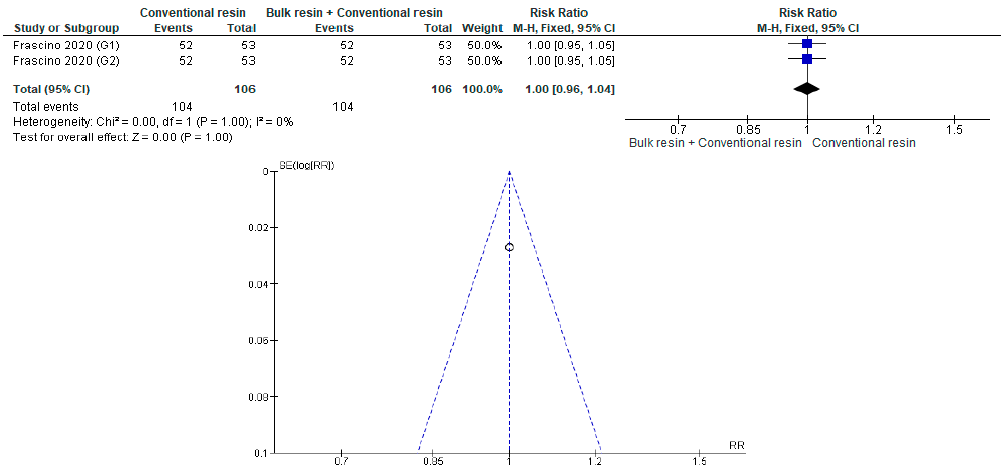
Figure A40. Adequate Tooth Integrity: Conventional Resin versus Bulk Resin Covered with Conventional Resin.